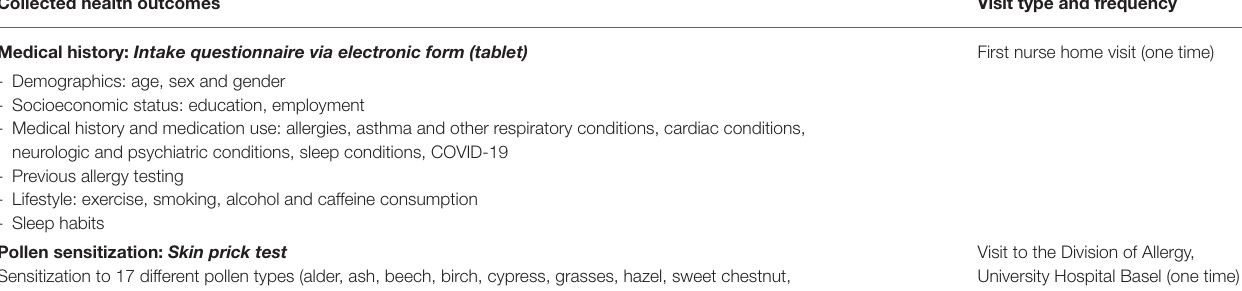
TABLE 1 | Health outcomes collected in the EPOCHAL study ( bold ), assessments and questionnaires ( bold italics ), details on health outcomes (normal font). Collected health